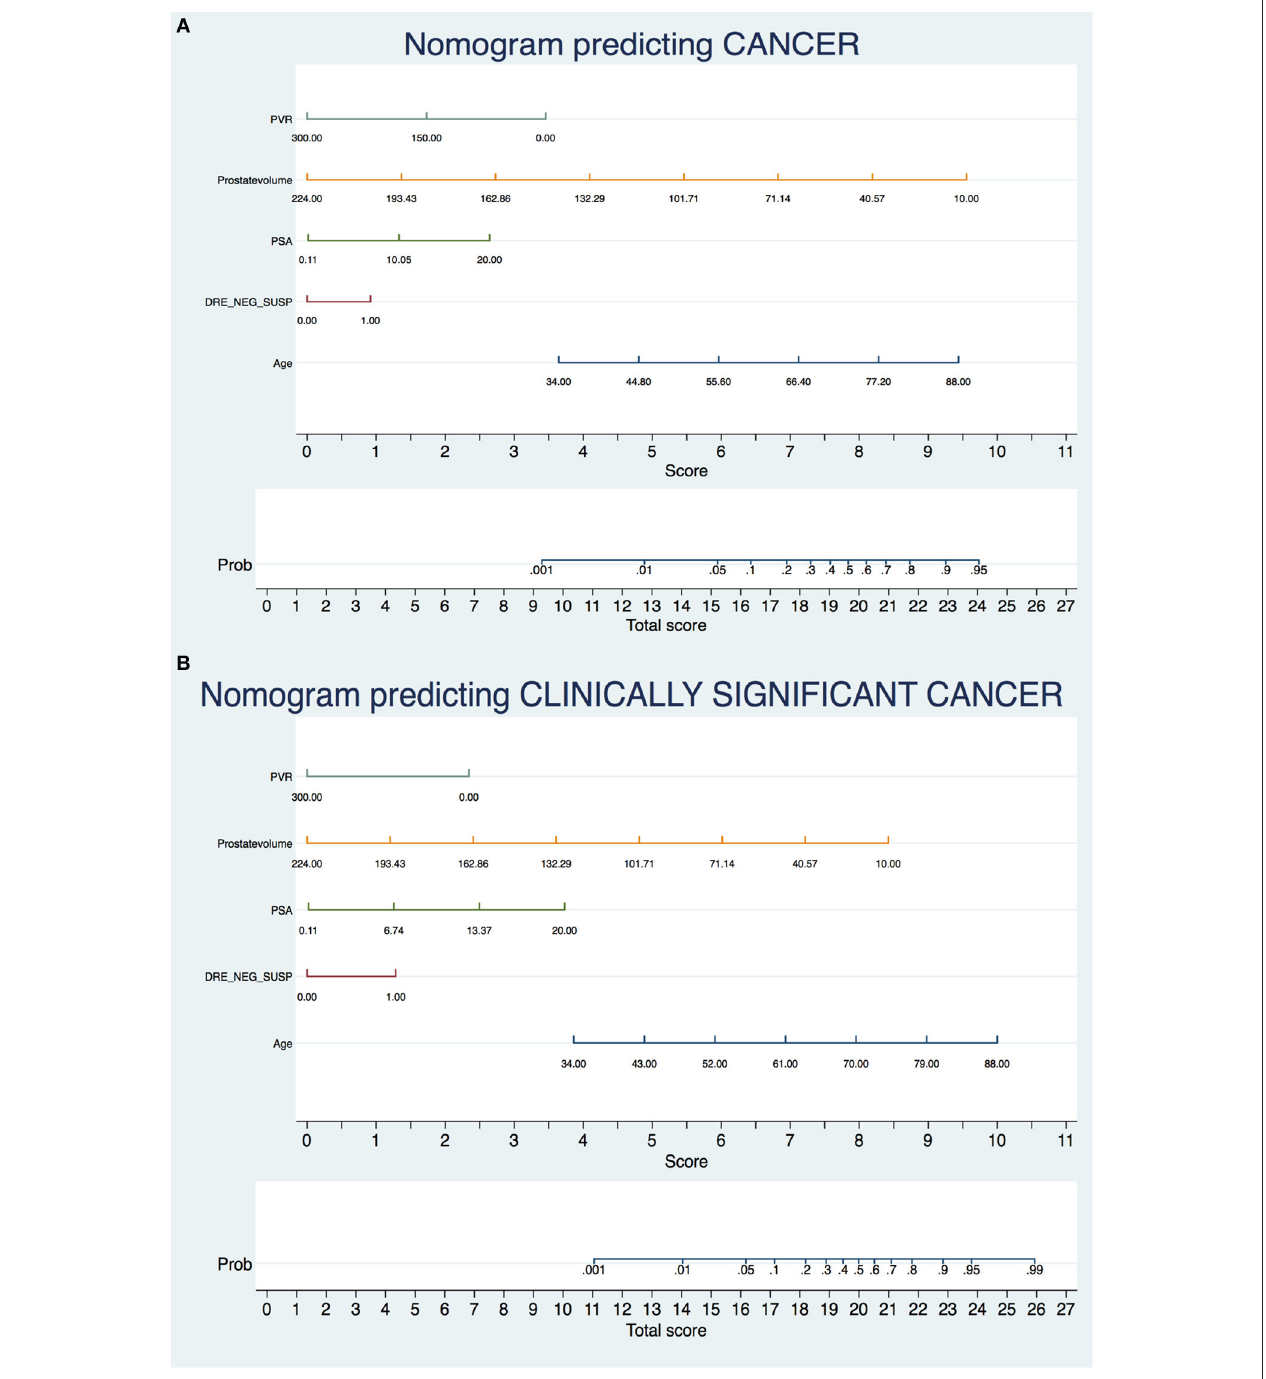
FIGURE 2 | Nomograms predicting prostate cancer (A) and clinically significant prostate cancer (B)